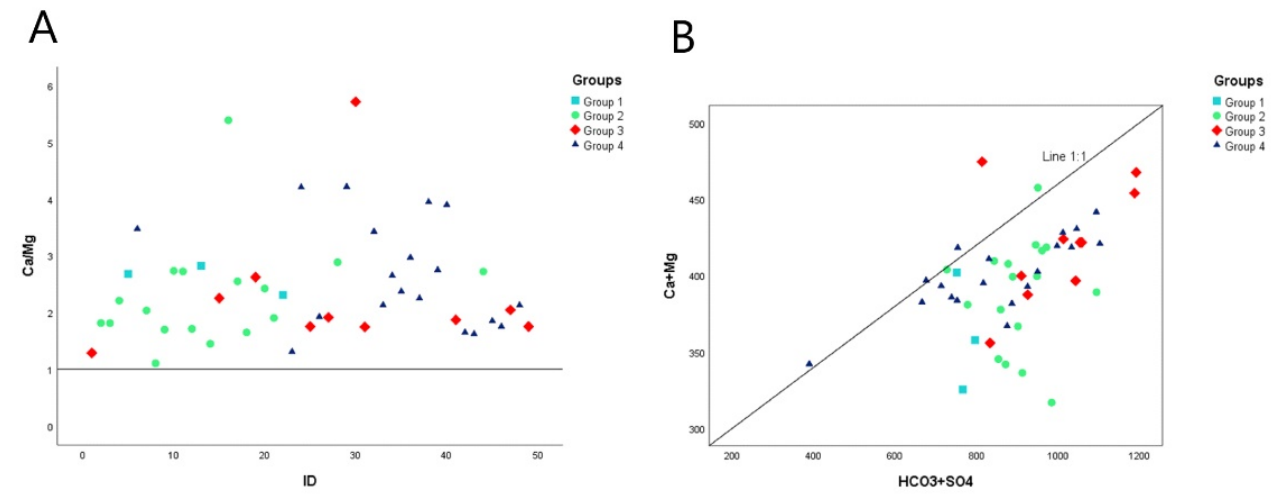
Figure 10. ( A ) Bivariate plots of a good number vs. Ca 2+ /Mg 2+ , and ( B ) bivariate plots of Ca 2+ + Mg 2+ vs. HCO 3 − + SO 42 − .